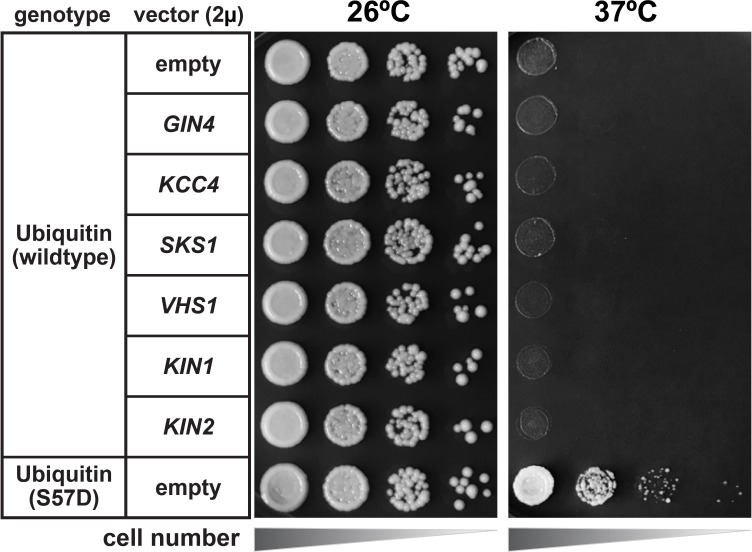
Heat stress growth phenotype of yeast strains overexpressing Ser57 ubiquitin kinases.SUB280 cells harboring the indicated kinases cloned into a 2µ multicopy plasmid pRS327 were serially diluted onto lysine-dropout synthetic media and grown at 26°C or 37°C for 3 days. KIN1 and KIN2 were included as control kinases in the Snf1-related family that did not exhibit Ser57 ubiquitin kinase activity in our screening (Figure 3—figure supplement 2).